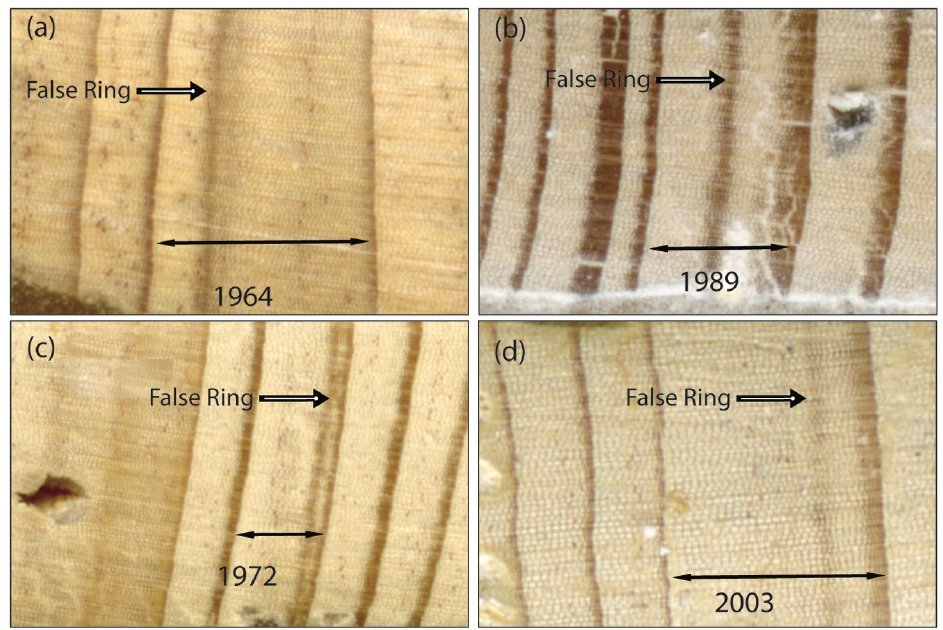
Figure 2. Microphotographs of Taxodium distichum annual rings (highlighted) showing false ring anatomy during four separate years. An “early” false ring (FR) is shown in ( a ), a “middle” FR in ( b ) and “late” in ( c , d ).